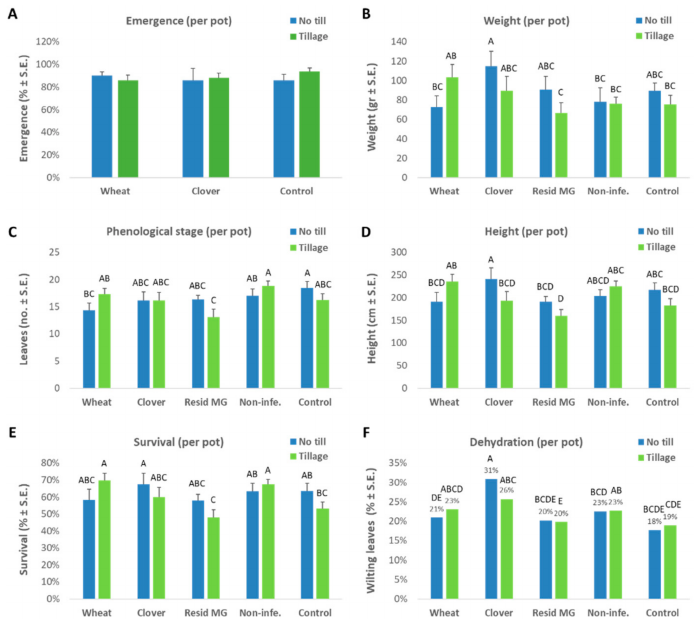
Figure 3. The greenhouse pot experiment—emergence evaluation (3 DAS) and growth parameters at the end of the sprouting phase (45 DAS). The greenhouse trial is described in Figure 1. The plants’ growth parameters (average per pot) included aboveground surface appearance ( A ), shoot fresh weight ( B ), phenological stage (the number of leaves, C ), and height ( D ). The Resid MG (or Mico) product powder was added one week after the sowing, and thus this treatment was not included in the emergence evaluation. The plants’ health status at that age was evaluated using survival percentages ( E ) and wilt assessment ( F ) that were based on the percentage of dry leaves in each repeat. Non-infe.—reduced-infected soil control. Values represent an average of 10 replications (pots, each containing five plants) ± standard error. Statistically significant differences (one-way ANOVA, p < 0.05) between treatments at the same measures (if they exist) are indicated by different letters